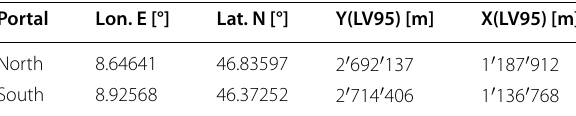
Table 2 Location of the GBT southern and northern portals, which have been used to define the start and the end point of the reference model line and the projections